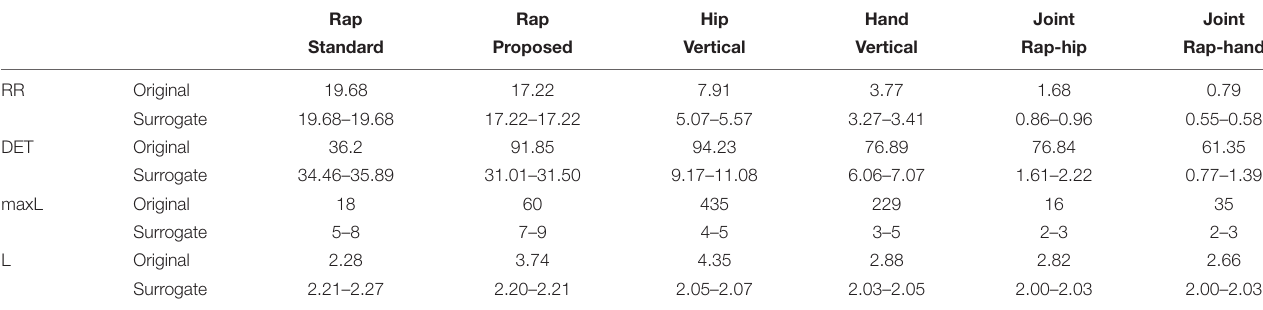
TABLE 1 | Recurrence quantification analysis measures. Rap Rap Hip Hand Joint Joint Standard Proposed Vertical Vertical Rap-hip